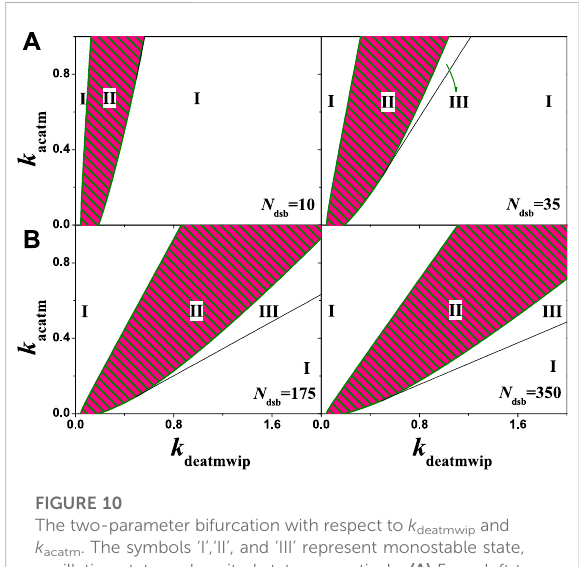
The two-parameter bifurcation with respect to k deatmwip and k ‘ I ’ , ‘ II ’ , and ‘ III ’ represent monostable state, acatm . The symbols oscillation state and excited state respectively. (A) From left to right, N dsb = 10,35 respectively. (B) From left to right, N dsb = 175, 350 respectively. Either in A or B, the same ordinate system is used for the left and right